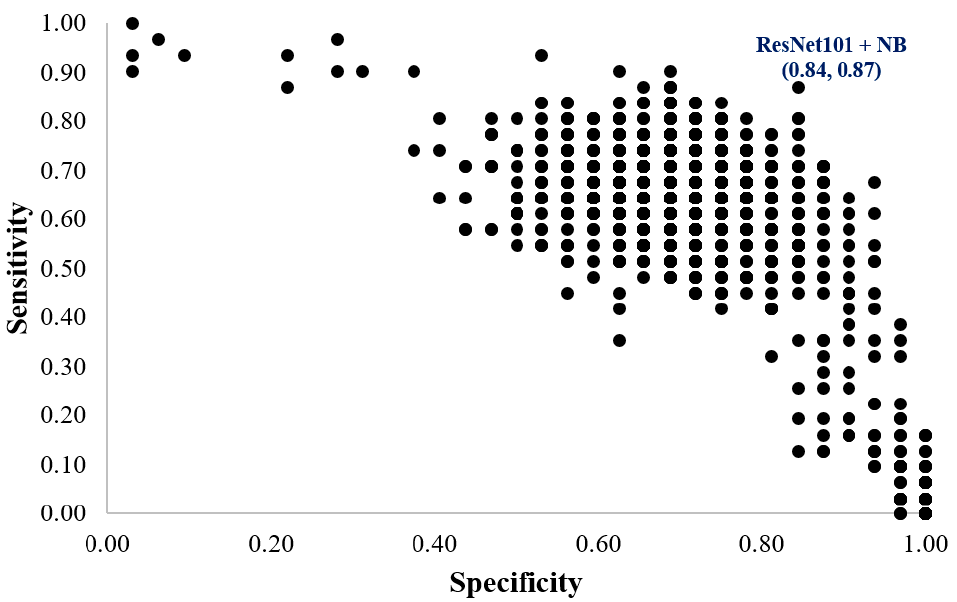
Figure 4. Scatter plot for the specificity and sensitivity of the 1920 models for the validation dataset.